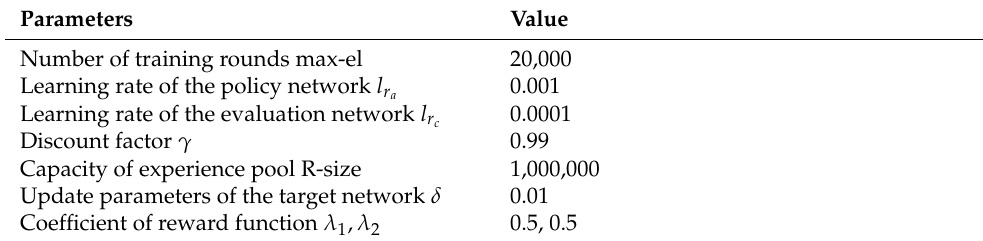
Table 4. Parameter setting of MADDPG